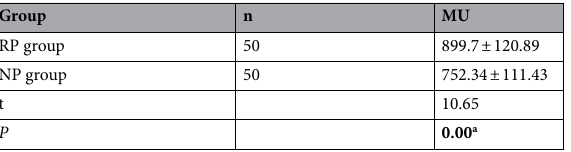
Table 3. Dosimetry comparison for the MU of RP group and RP group (mean ± SD). *a = Paired t test, P < 0.05. Bold values indicates that the difference is statistically significant ( P <0.05)